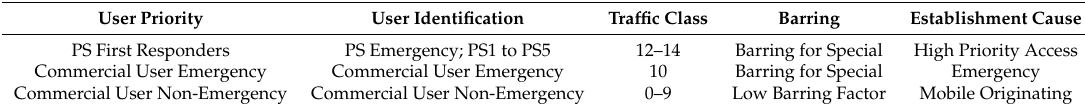
Table 2. Users’ priority table for PS LTE